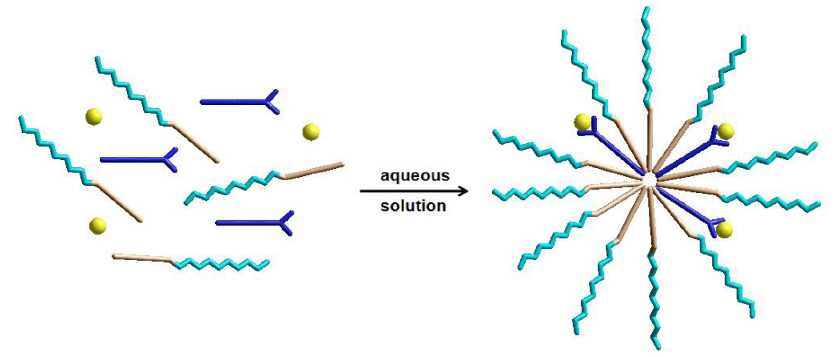
FIGURE 2 - Schematic representation of PEO-PE polymeric micelle formation labeled with 99m Tc. Micelle is formed spontaneously in aqueous media by self-assembled amphiphilic polymers, such as PEO-PE units (the soluble and insoluble blocks are light blue and brown, respectively). The radioactive compound (yellow spheres) is incorporated into the micelle through the amphiphilic polychelating agent, PE-DTPA (dark